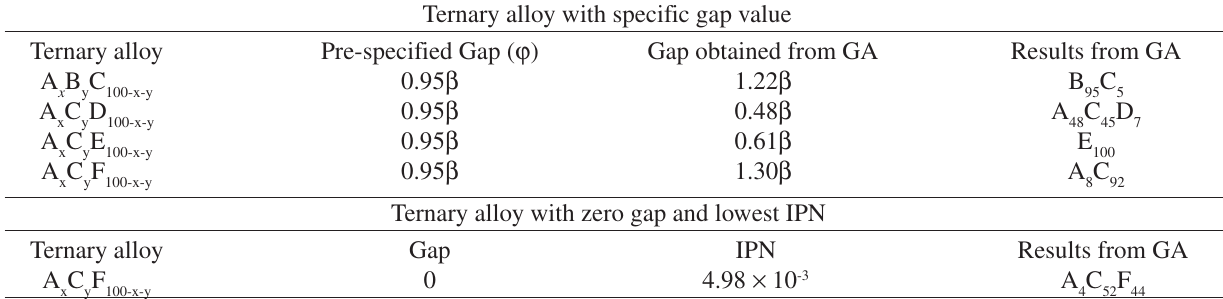
Table 2. Results obtained from GA simulations for ternary alloys. β = 2.5 eV.